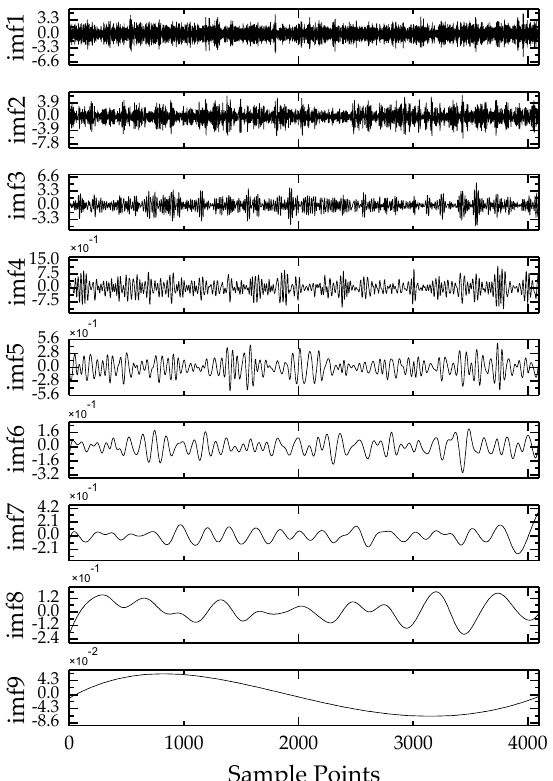
Figure 9. EEMD decomposition results of underwater acoustic signals.